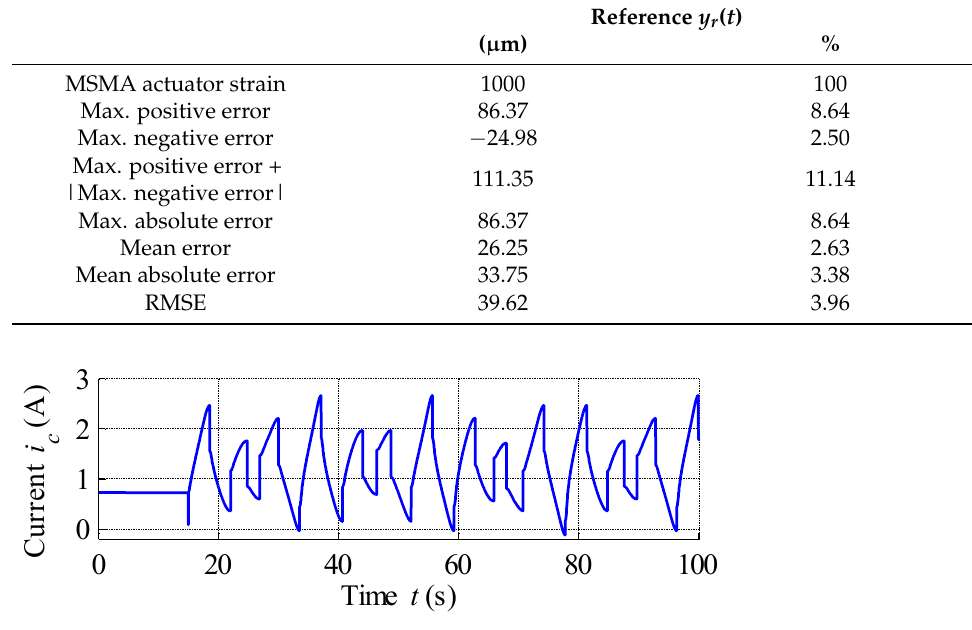
Figure 19. Compensation error.